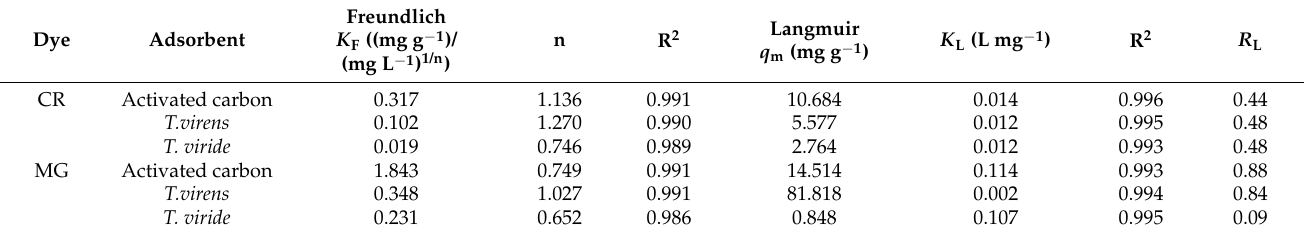
Table 3. Langmuir and Freundlich adsorption isotherm parameters. Initial concentrations ( C 0 ) of dye, 15 mg/L.